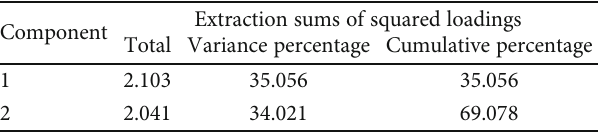
Table 2: Explanation of total variance.